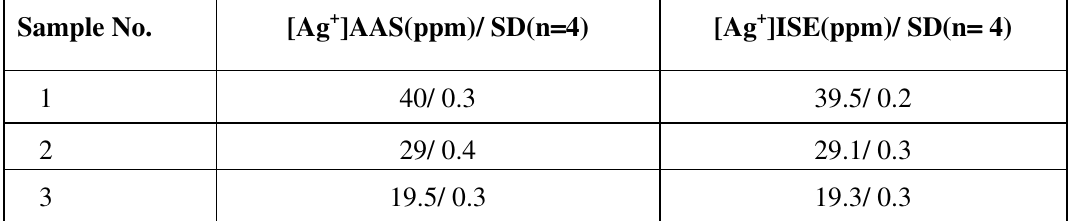
Figure 4. Plot showing the potentiometric titration of 1.0 × 10 -1 M of AgNO NaCl solution. Table 2. Analysis of water sample spiked with